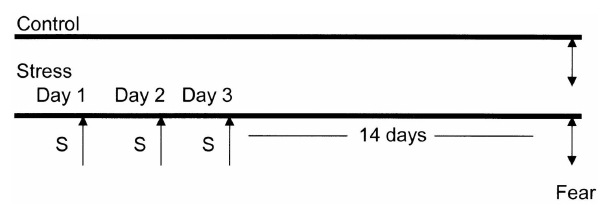
FIGURE 1 | Diagrammatic representation of the animal stress protocol . Amygdala complex (A) from control group ( n = 10) and stressed group ( n = 10) were dissected 14days after cessation of 3days stress